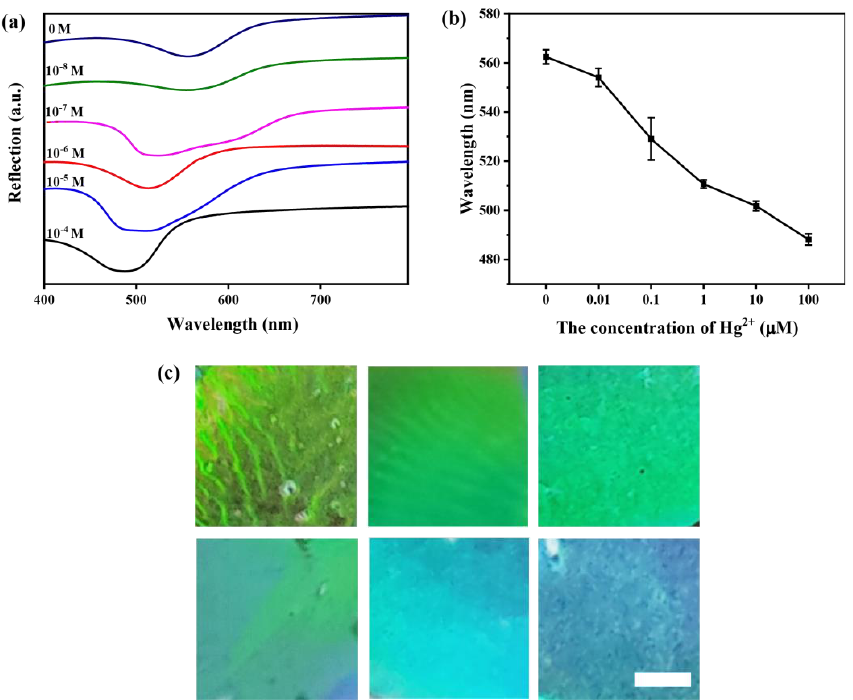
Figure 11. ( a ) The UV-visible reflection spectra of CLC-PAA urease PC films at different concentrations of Hg 2+ (The films were treated with 10 mM urea for 10 min.); ( b ) The wavelength values of the reflection light of CLC-PAA urease PC films at different concentrations of Hg 2+ ; ( c ) The optical images of CLC-PAA urease PC films at different concentrations of Hg 2+ . scale bar: 1 mm.